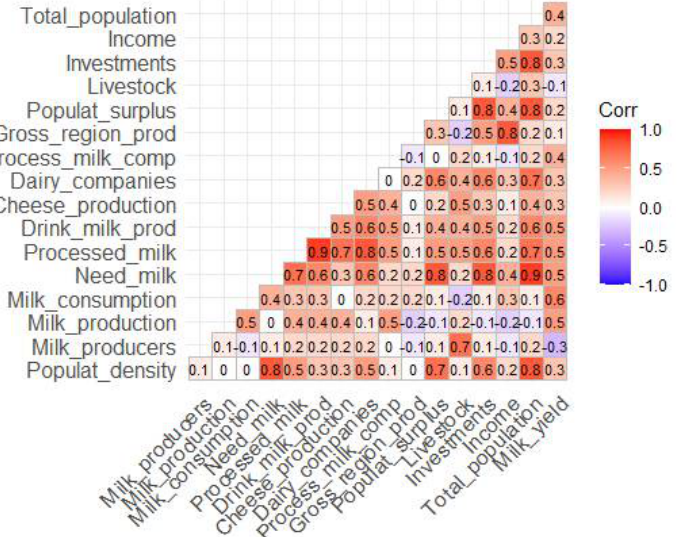
Figure A3. Correlation plot for all 17 collected explanatory variables Red color in the correlation plot indicates the correlation coefficients greater than zero; blue color indicates the correlation coefficients smaller than zero).